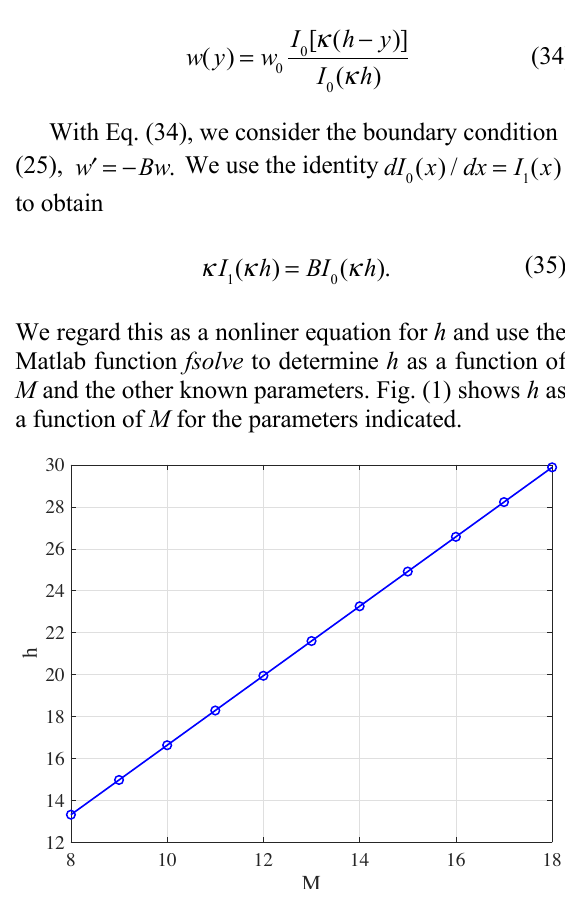
Fig. 1 Dimensionless flow height versus dimensionless mass hold-up for e = 0.80, µ = 0.10, f = 0.29 (16.6 o ), and q = p